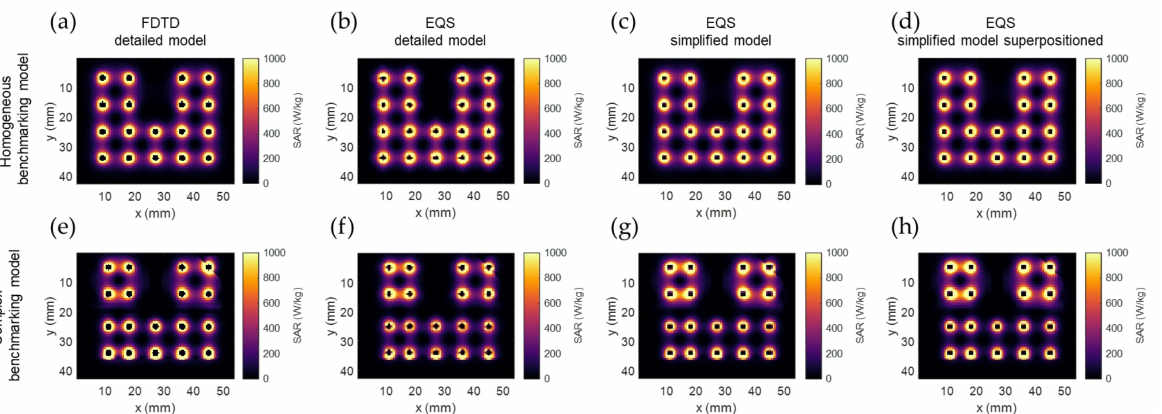
Figure 3. Schematic representation of the homogenous ( A – C ) and complex ( D – F ) benchmark models in axial view ( A , D ), sagittal view ( B , E ), and a 3D view ( C , F ). The noted dimensions correspond to the volume of interest used for the simulation comparison and the distance between the applicators. The plane denoted in green corresponds to the slice visualized in Figure 4.